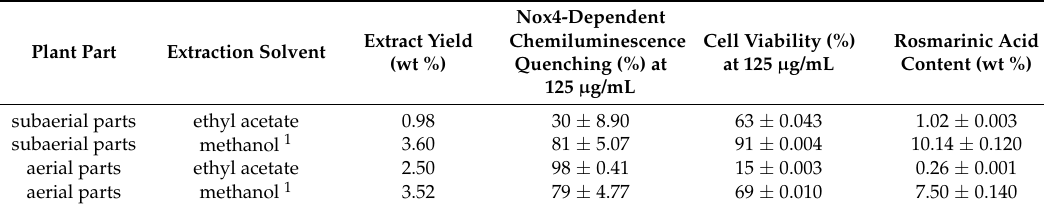
Table 1. Effects of extracts of L. europaeus on Nox4 inhibitory activity and cell viability (mean of two independent experiments, each performed in triplicate) and rosmarinic acid content of the extracts ( n = 2, analyzed in triplicate ±